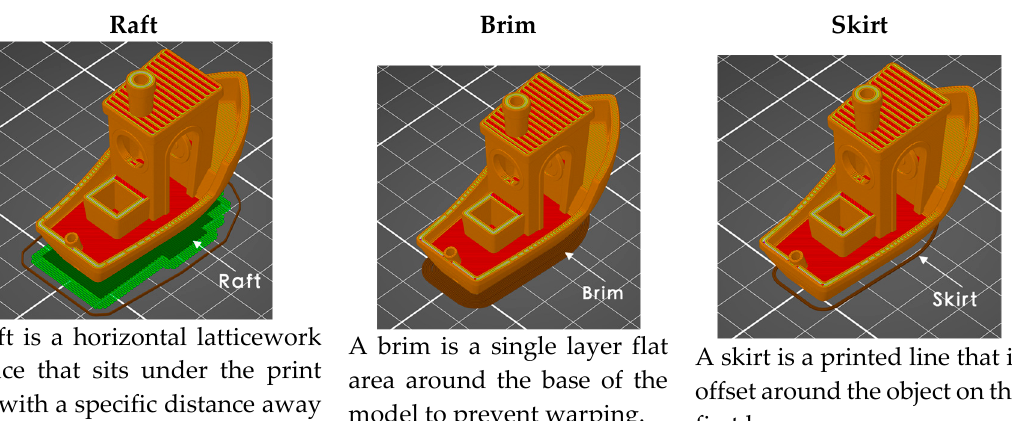
Table 4. Build direction and its effects on part weakness